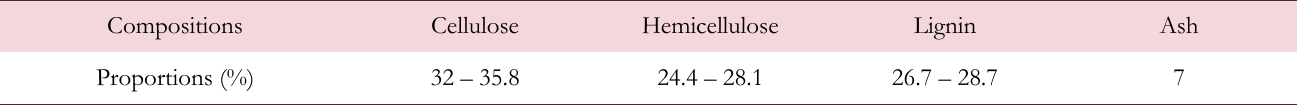
Table 9: Chemical composition of Date Palm fiber mesh [19].